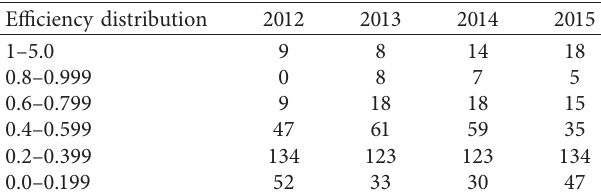
Table 4: Efficiency distribution of high-tech SMEs